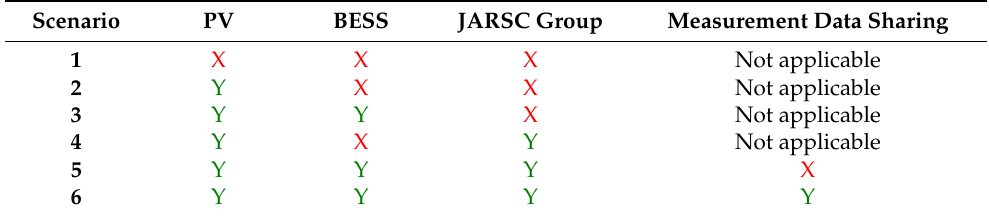
Table 6. Considered simulation